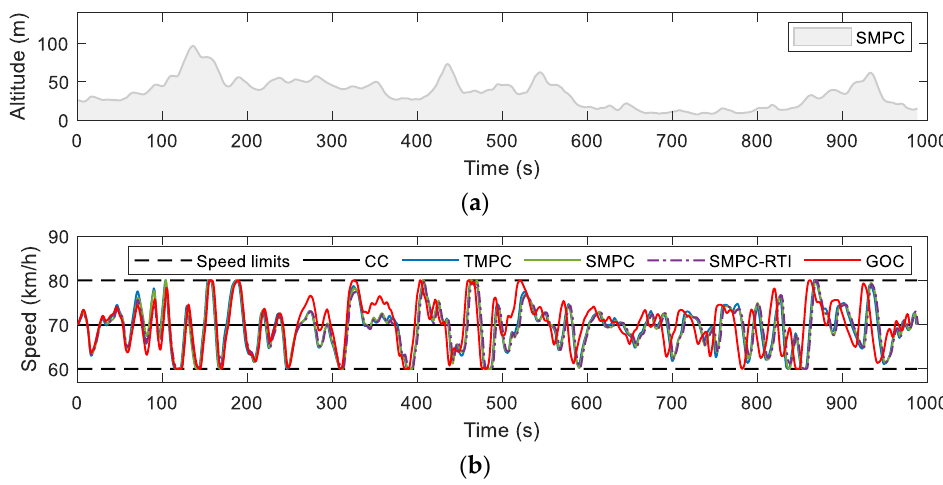
Figure 9. Road altitude and vehicle speed results on the expressway. ( a ) Road altitude against driving time in SMPC. ( b ) Vehicle speed results of different speed controllers.